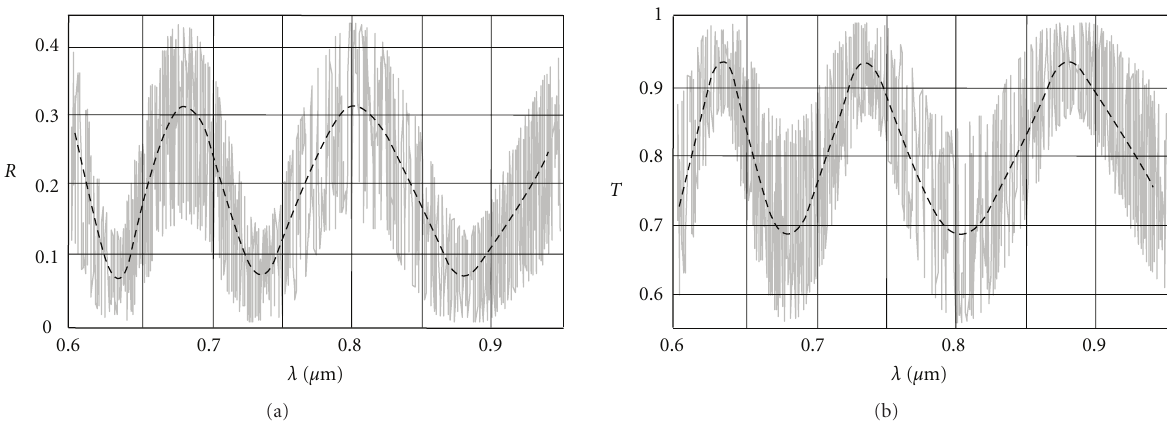
Figure 2: Reflectance ( R ) and transmittance ( T ) spectra of the Ta 2 O 5 -quartz-glass structure calculated from (4) and shown by gray lines in the form of a “beard”. Dashed curves on the spectra result from measurements by using a spectrophotometer with operating slit of finite